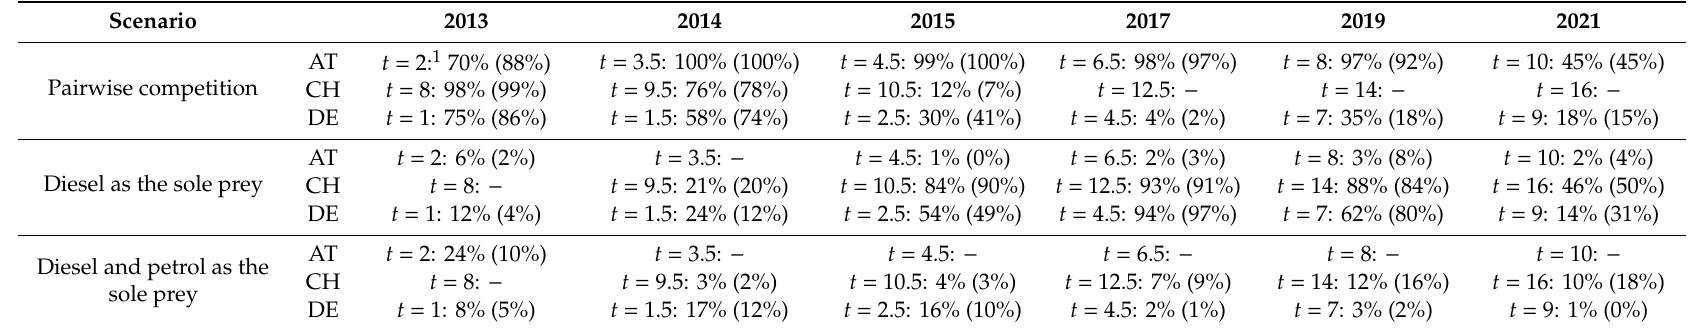
Table 3. Percent (and percent of total weight) of simulations resulting in certain